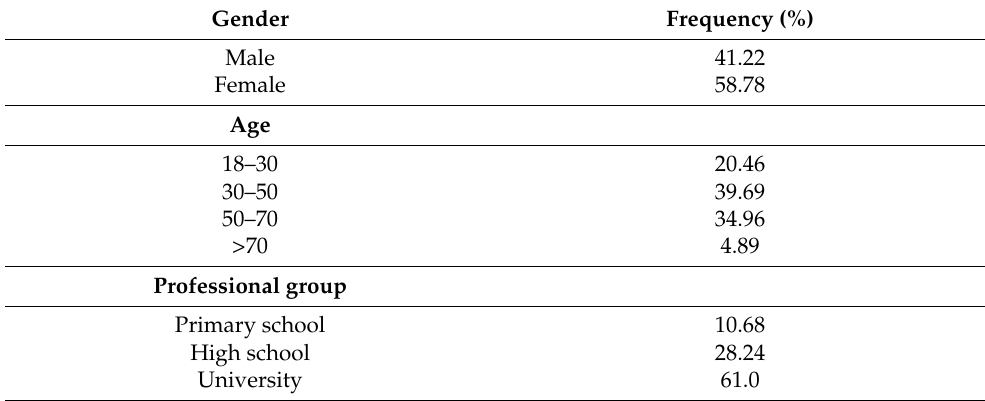
Table 2. Distribution of socio-demographic characteristics of the second